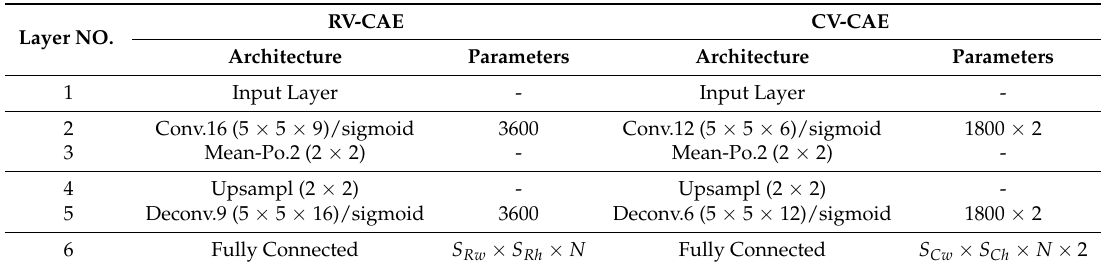
Table 2. The Structure and Parameters Number of RV-CAE and